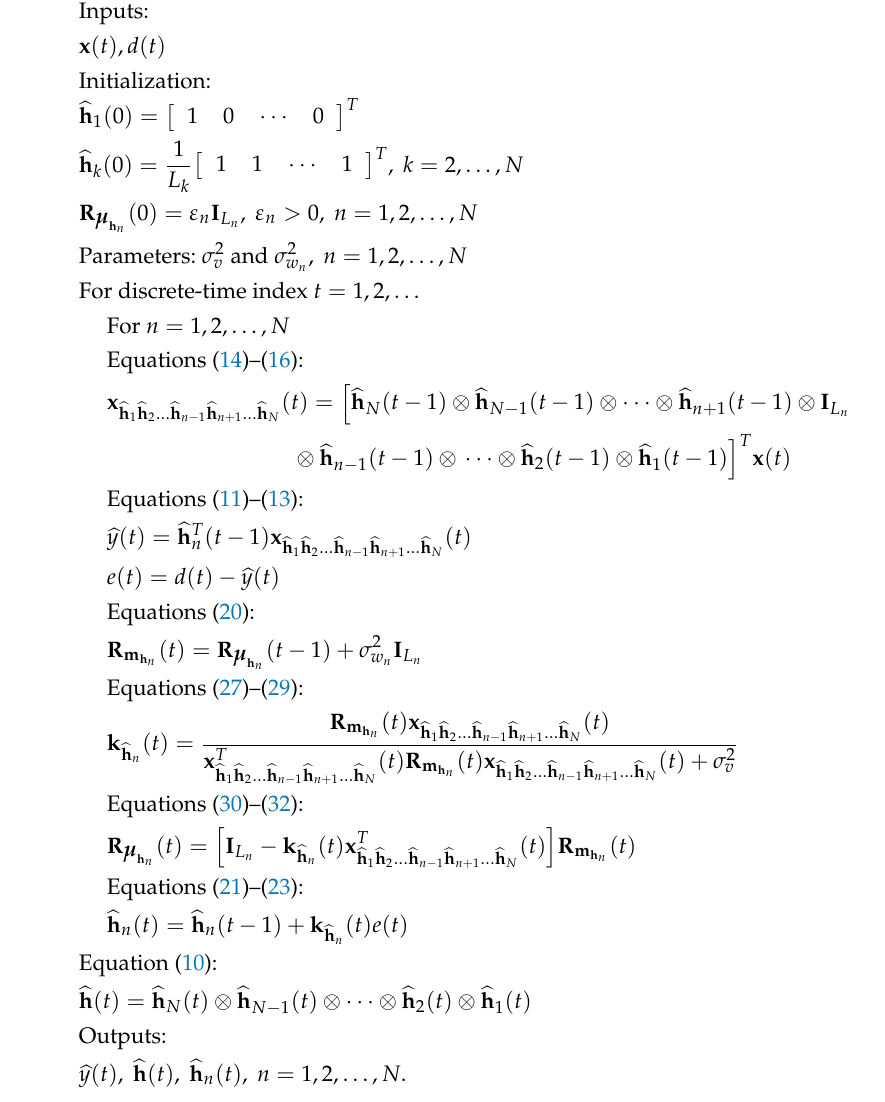
Table 1. Tensor-based Kalman filter (KF-T) for multilinear